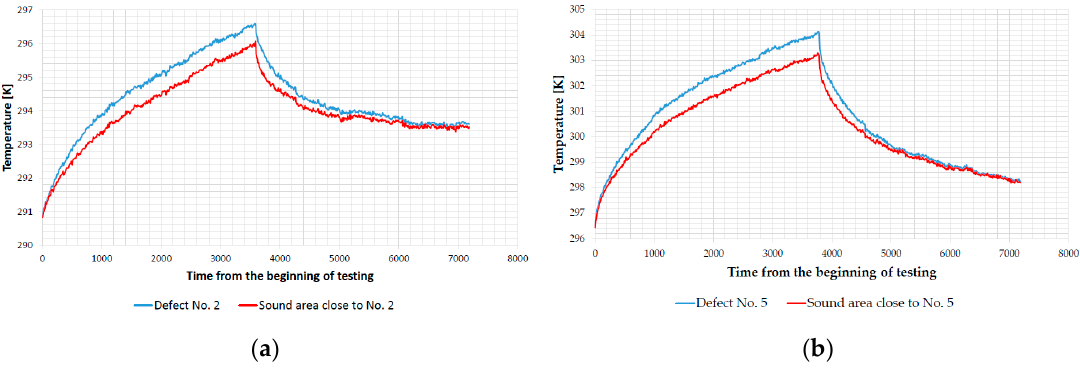
Figure 4. Surface temperature development: ( a ) BM 2–2–thermal excitation distance 2 m, top side, defect No. 2; ( b ) BM 3–2–thermal excitation distance 2 m, top side, defect No. 5.